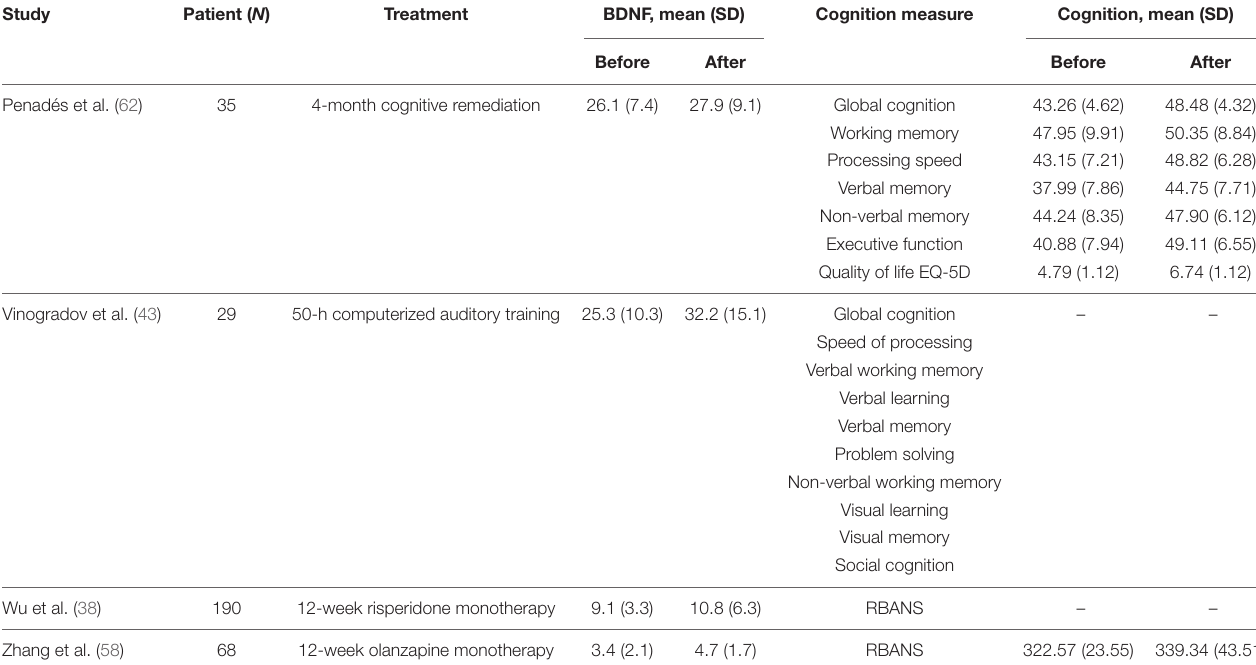
TABLE 4 | Brain-derived neurotrophic factor levels and cognition scores at baseline and after treatment.